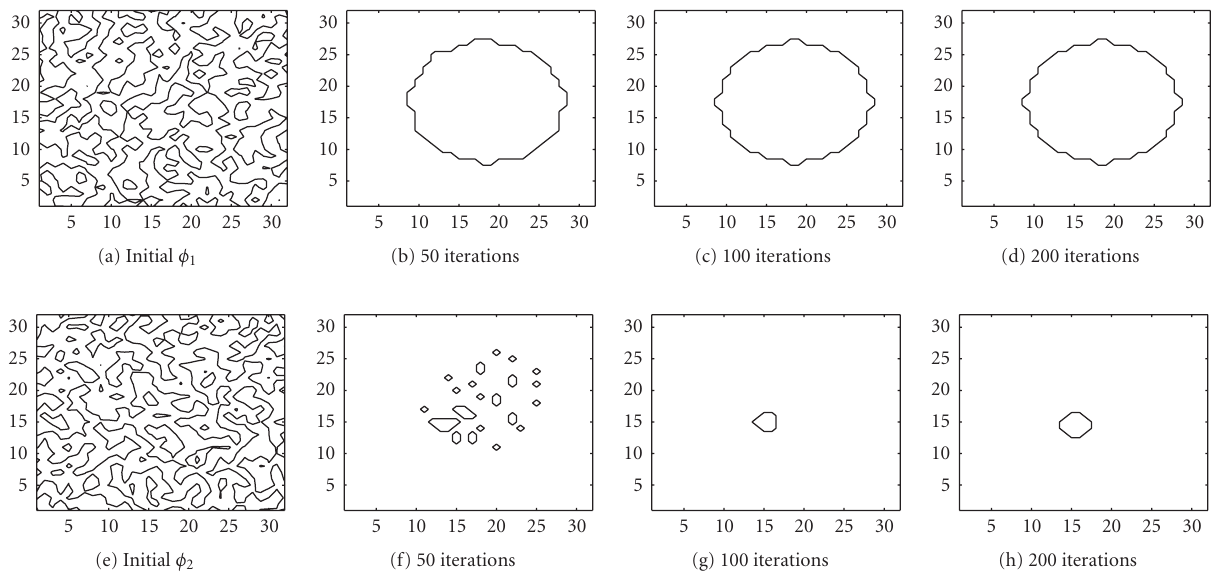
Figure 4: Interfaces given by the zero level set of the function φ 1 and φ 2